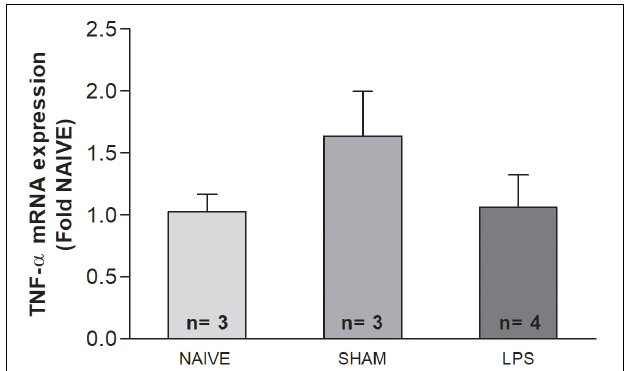
FIGURE 5 | The mRNA level of TNF- α in the cerebellum of adult rats (PN89) after early neonatal LPS induced inflammation. The TNF- α mRNA concentration was not altered in adult rats submitted to systemic inflammation as neonates. Values: bars represent the (cid:49) Ct values ( ± SEM) of TNF- α mRNA expression normalized to the mean of Hprt and Actb. ANOVA, p >